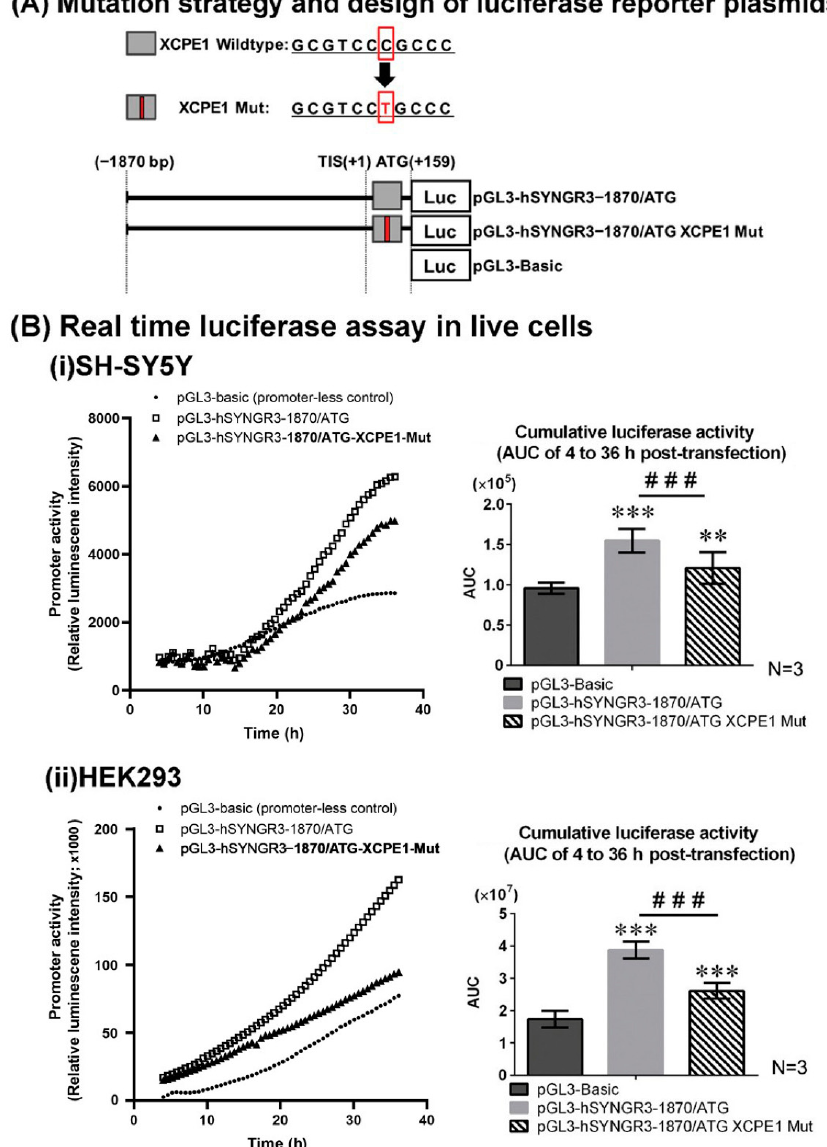
Figure 4. Effects of wildtype and mutated XCPE1 on SYNGR3 promoter activity monitored by a real-time luciferase assay in neuronal SH-SY5Y and non-neuronal HEK293 cells. ( A ) Construction of luciferase-plasmids with XCPE1 site-directed mutation. ( B ) (i) Real-time luciferase assay comparing wildtype and mutant XCPE1 in SH-SY5Y cells; and (ii) in HEK293 cells. Data are expressed as mean ± SEM of three replicates. **, p < 0.01, *** p < 0.001 compared with control (pGL3-Basic) construct. ###, p < 0.001, compared between the two designated groups.